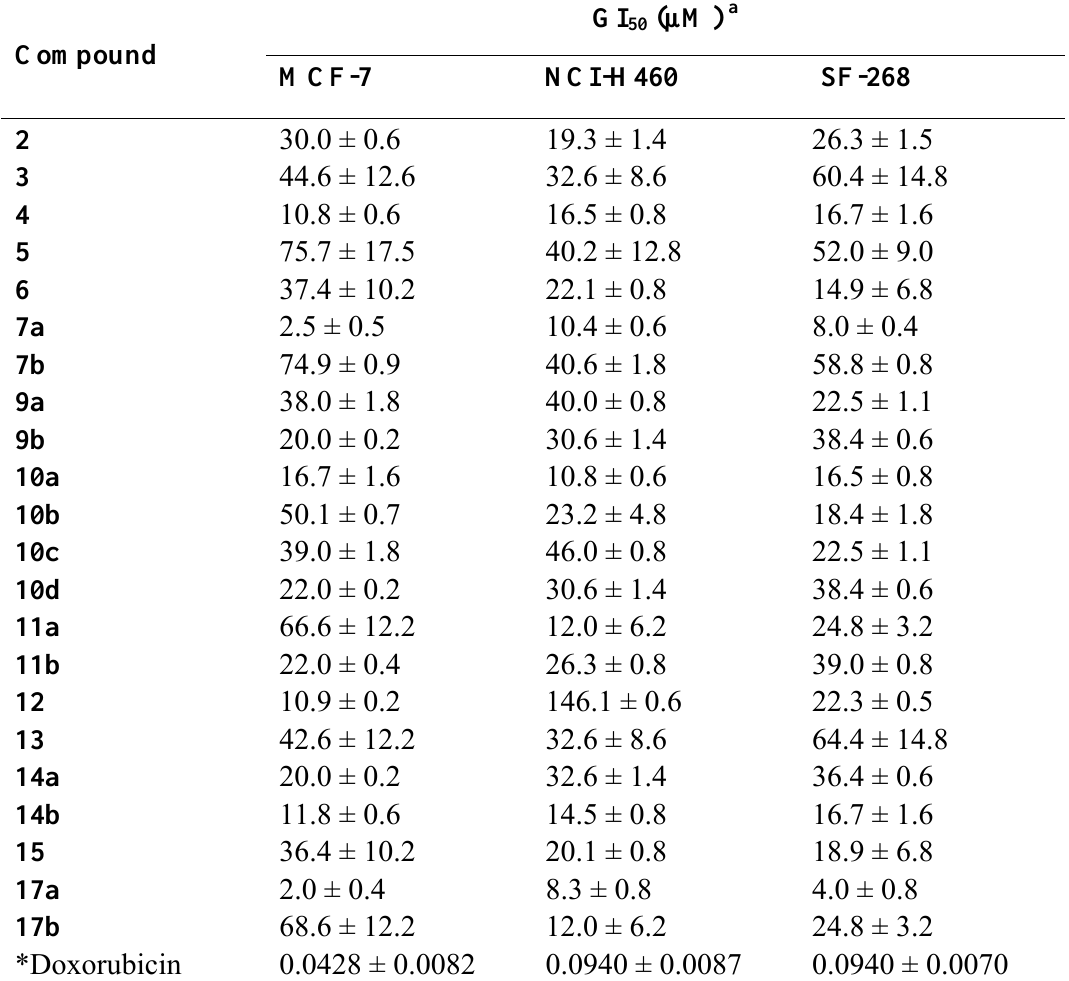
(µM) of the synthesized 50